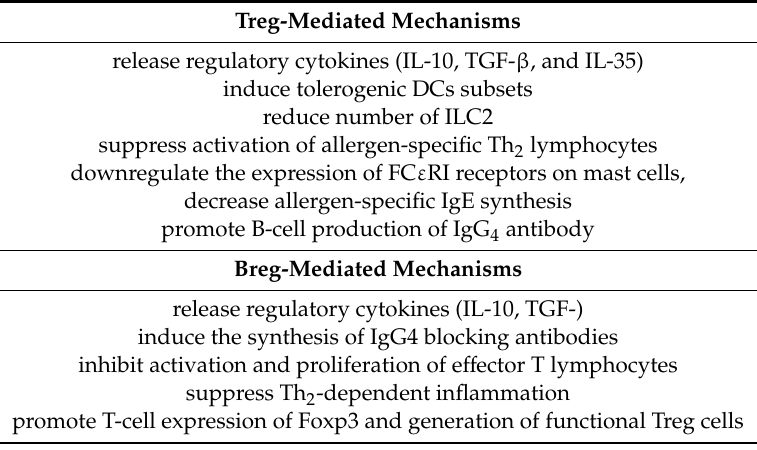
Table 1. Mechanisms of immunologic tolerance mediated by T and B regulatory cells during allergen immunotherapy.